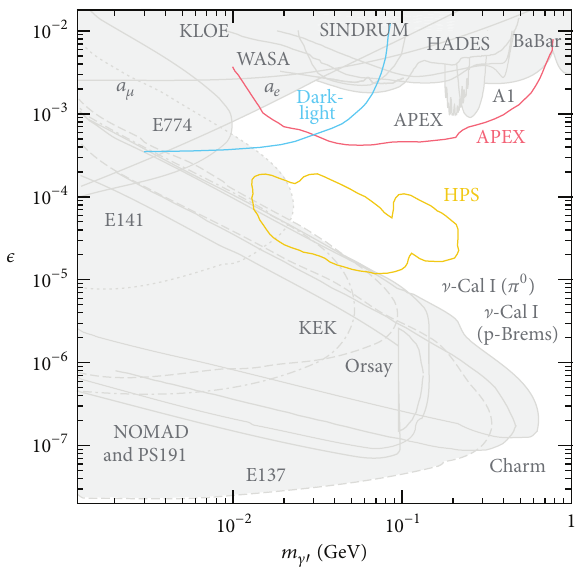
Figure 1: Excluded region in the plane 𝜖 - 𝑚 𝛾 󸀠 resulting from presently available data. Electron beam dump experiment covers the region of low masses and very low couplings, down to 𝜖∼10 −7 . For higher masses and lower couplings limits come mainly from meson decays and electron-nucleon scattering experiments and to B-factories data (plot courtesy of S. Andreas). The plot reports also the projections for the experiments presently under construction. For details on single experiments see